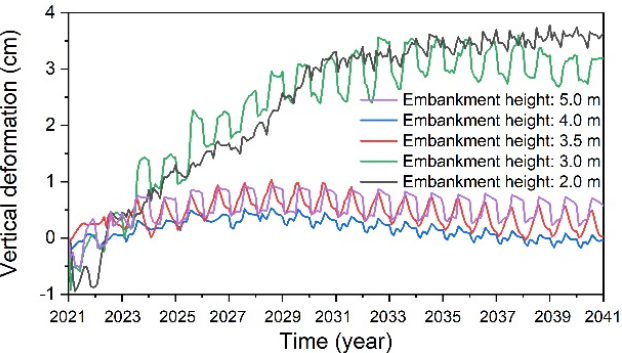
Figure 11. Curves of the variation in vertical deformation difference (uneven settlement) between the shoulders and the road centerlines of different structures.